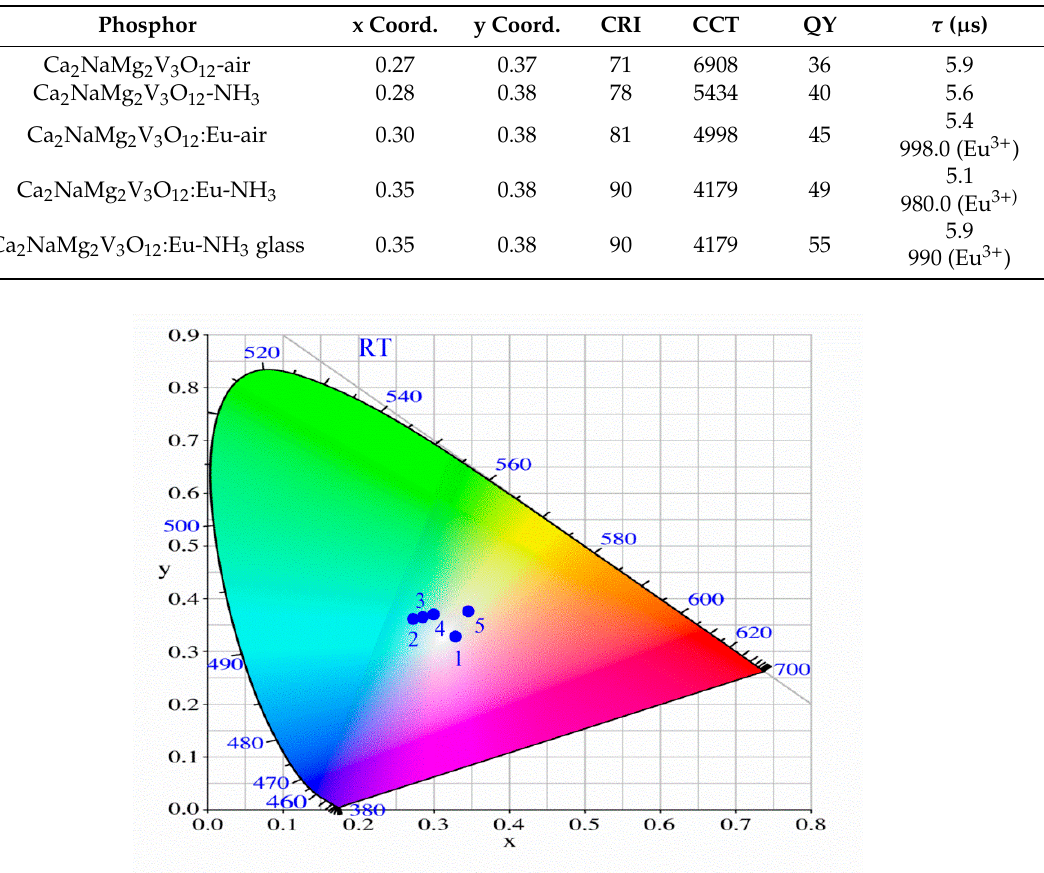
Figure 6. Color coordinates of Ca 2 NaMg 2 V 3 O 12 phosphors obtained in the air (2) and NH 3 (3) atmospheres; color coordinates of Ca 2 NaMg 2 V 3 O 12 : Eu (1%) phosphors obtained in the air (4) and NH 3 (5) atmospheres. 1: white point.